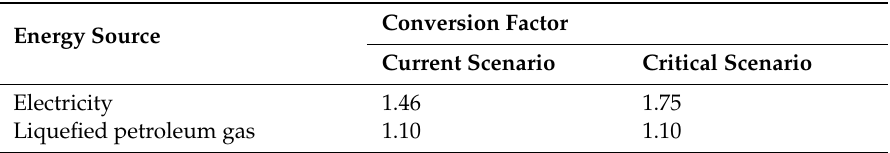
Table 5. Primary energy conversion factors for